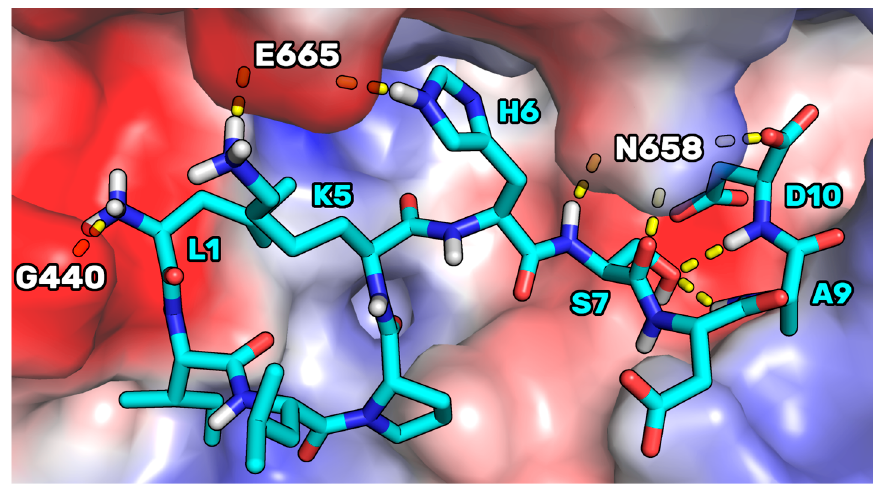
Figure 8. The representative structure of the most populated cluster of P5 (cyan sticks) bound to HMG-CoAR (electrostatic surface). H-bonds are represented by yellow dashed lines. Only polar hydrogens are shown in the figure.